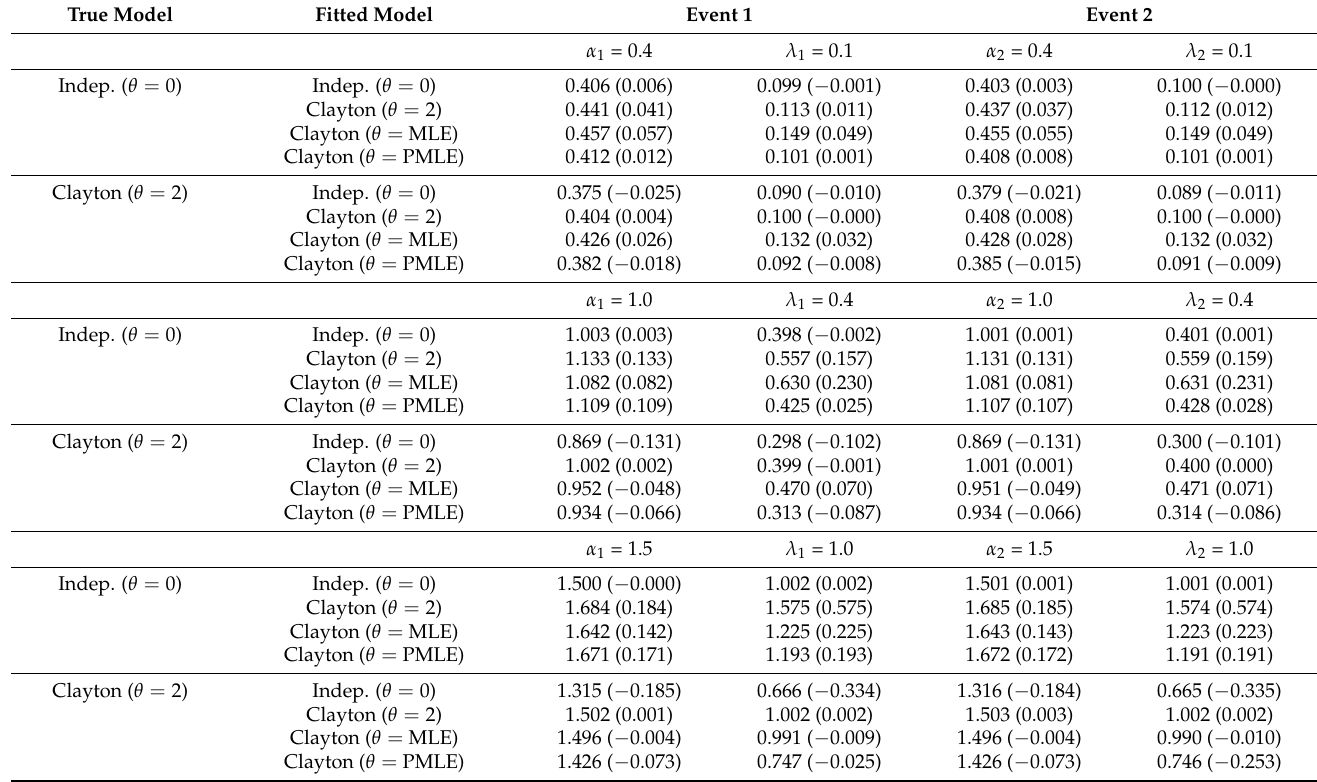
Table 1. The means (biases) of parameter estimates based on 1000 simulation